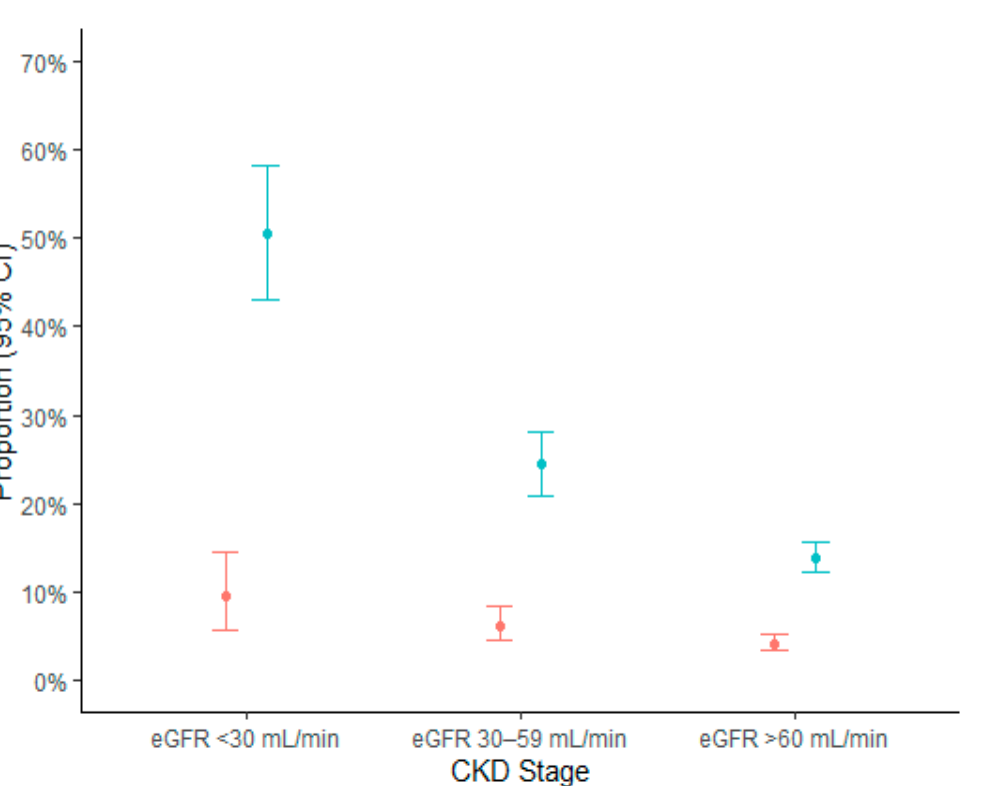
Table 4. Logistic model on the CKD effect on incident AF adjusted by age and sex. Patients with permanent AF were excluded from the model ( n = 96). n = 2720, AF = 143.